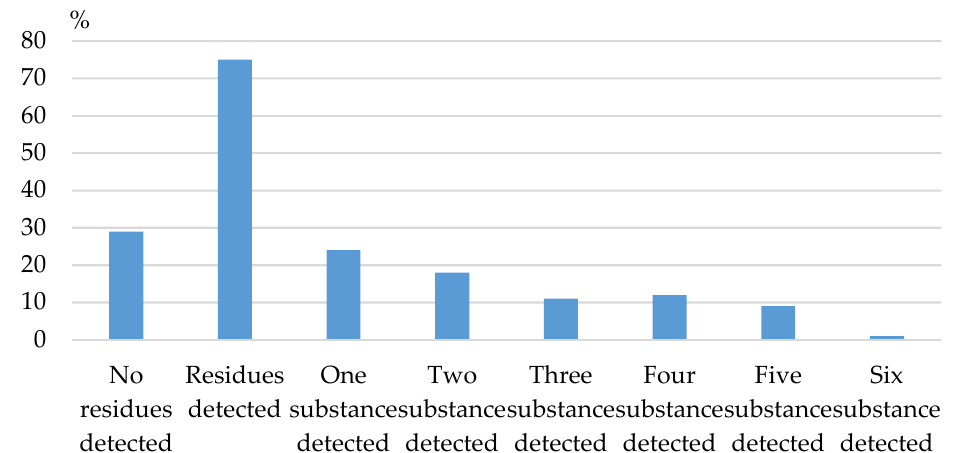
Figure 1. Distribution of samples with detected pesticide